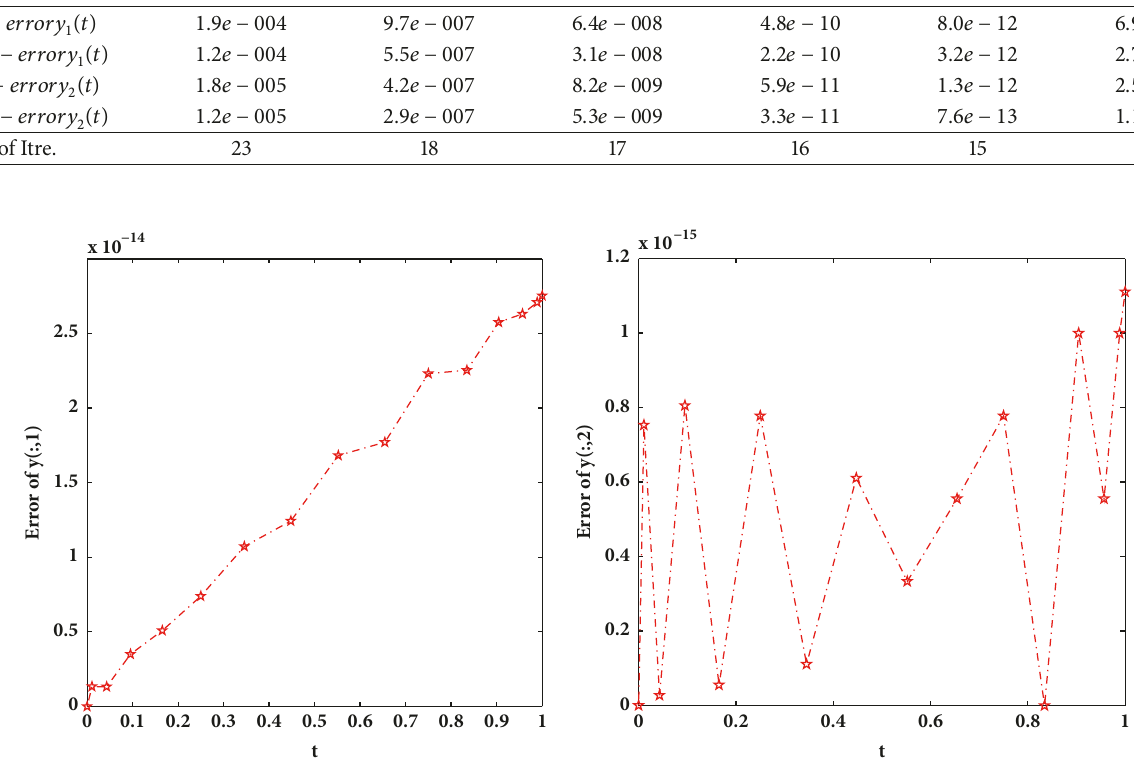
Figure 3: Errors of 𝑦 1 and 𝑦 2 for Example 3 when 𝑁 = 16